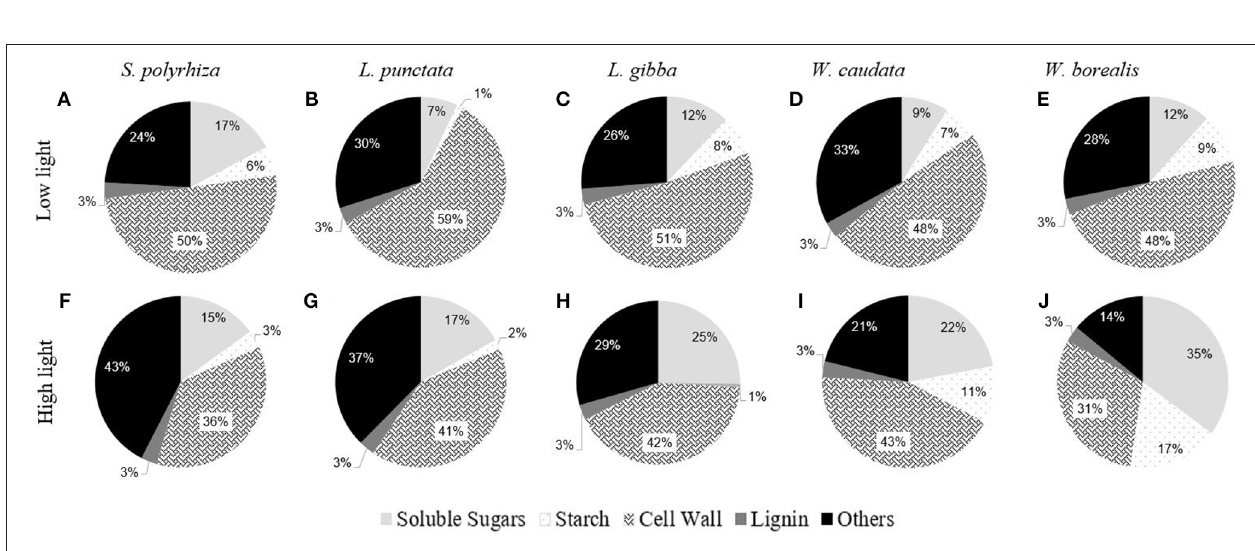
Frontiers in Chemistry | www.frontiersin.org